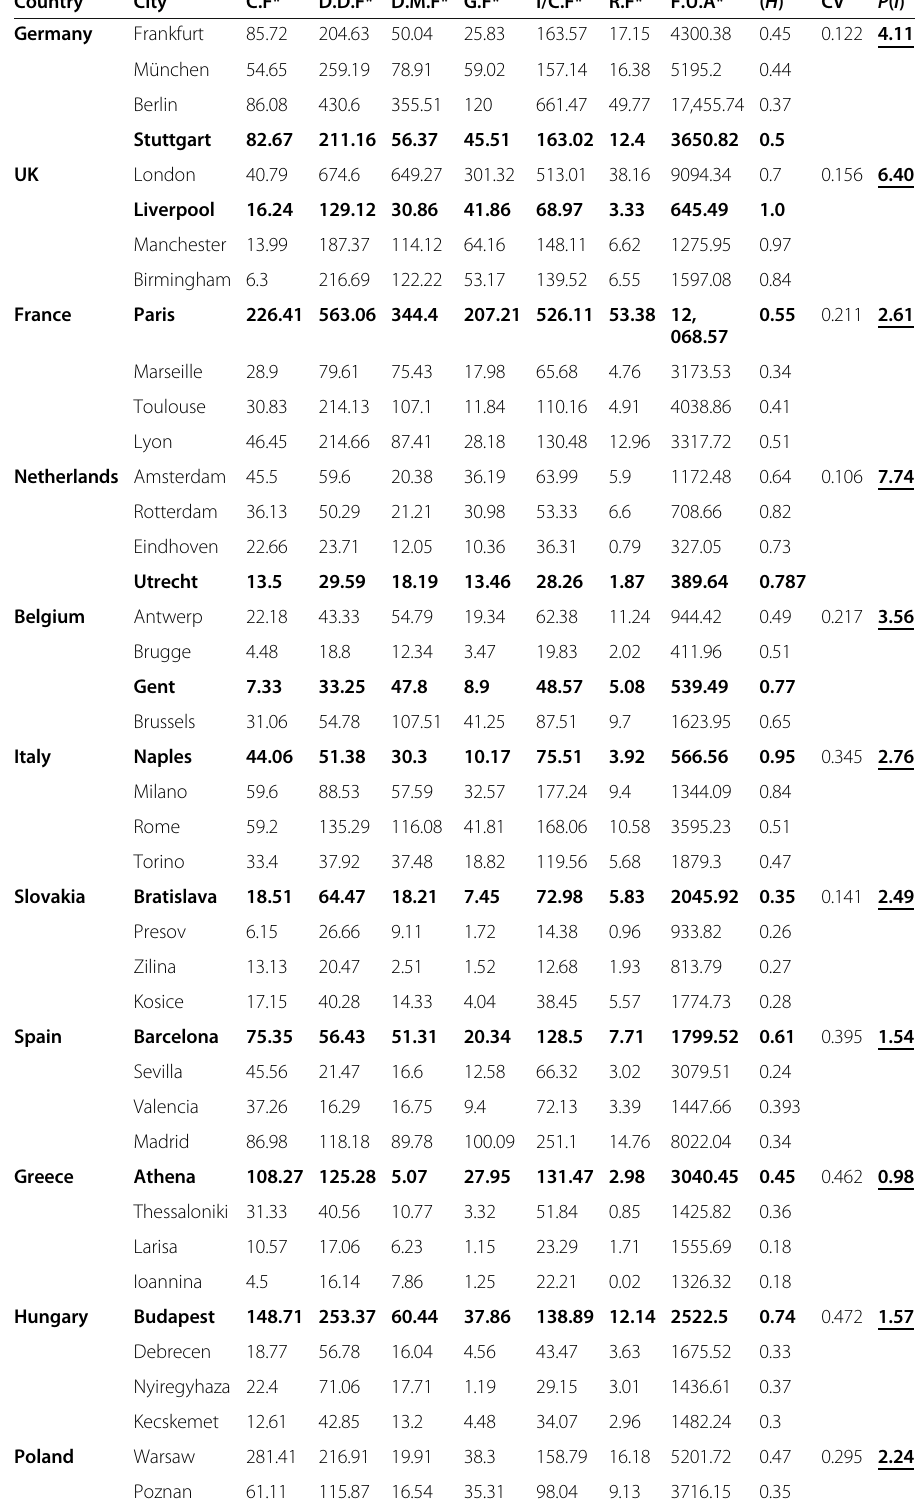
Table 2 Urban fabric land use areas for the 13 selected European countries